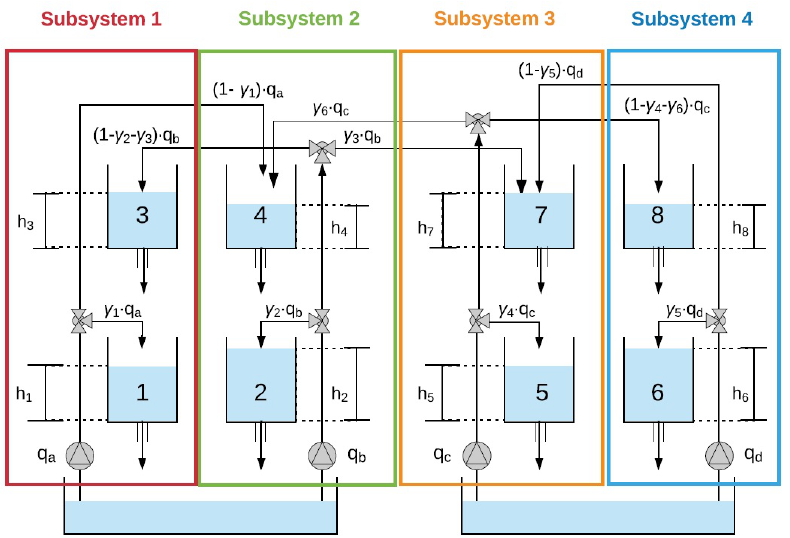
Figure 3. Schematic diagram of the eight-coupled tanks plant with the proposed